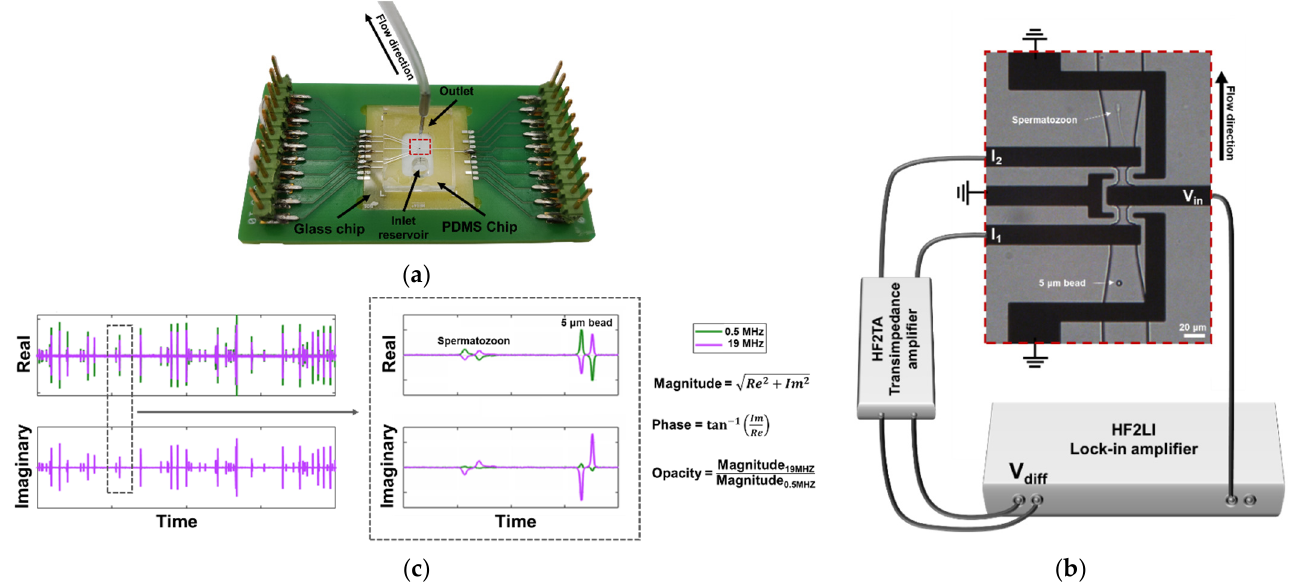
Figure 1. Overview of the chip. ( a ) Microfluidic impedance chip consisting of a PCB, glass chip and PDMS chip. ( b ) Microscopic image of electrodes and channels connected to the impedance spectroscope. The sensing zones are 10 × 10 × 20 µm 3 . An AC voltage is applied to the middle electrode (V in ), resulting in two currents at the two sensing electrodes (I 1 and I 2 ), which were then measured differentially (V diff ). ( c ) Example of the real and imaginary signal of a passing bead and spermatozoon, respectively. The data were used to calculate the magnitude, phase and opacity of each event.